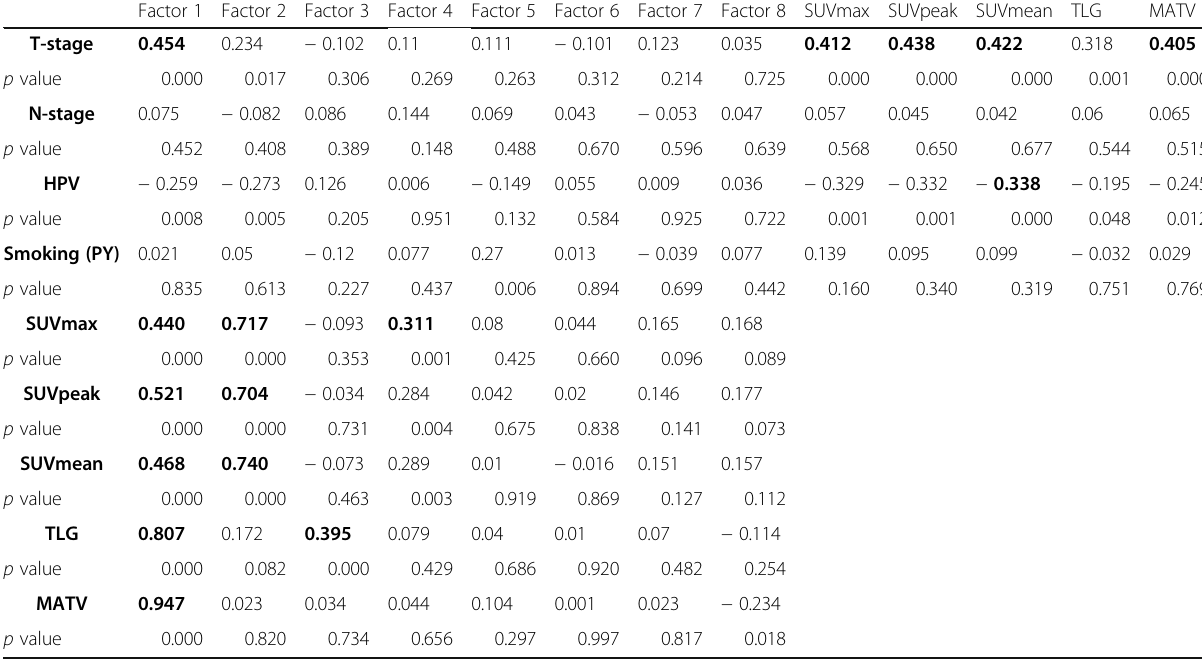
Table 2. Correlations of radiomic factors with clinical parameters and FDG-PET parameters in the training set